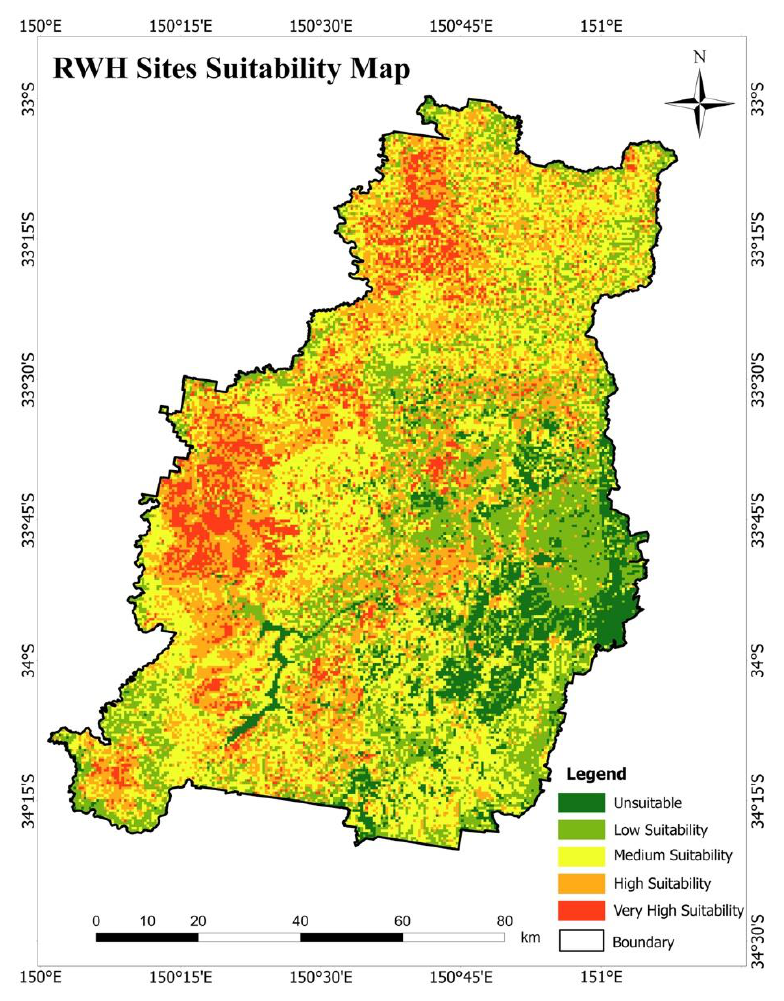
Figure 14. RWH final suitability map of the study area.